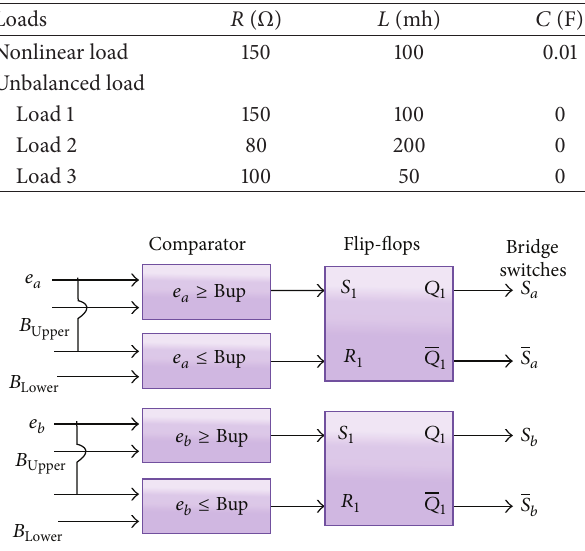
Table 1: Model parameters for unbalanced load.